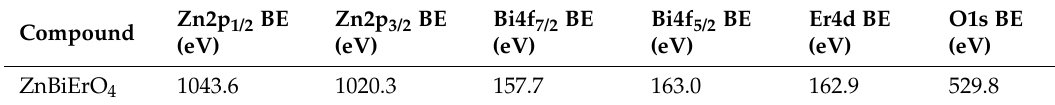
Table 2. Binding energies (BE) for key elements from ZnBiErO 4 .